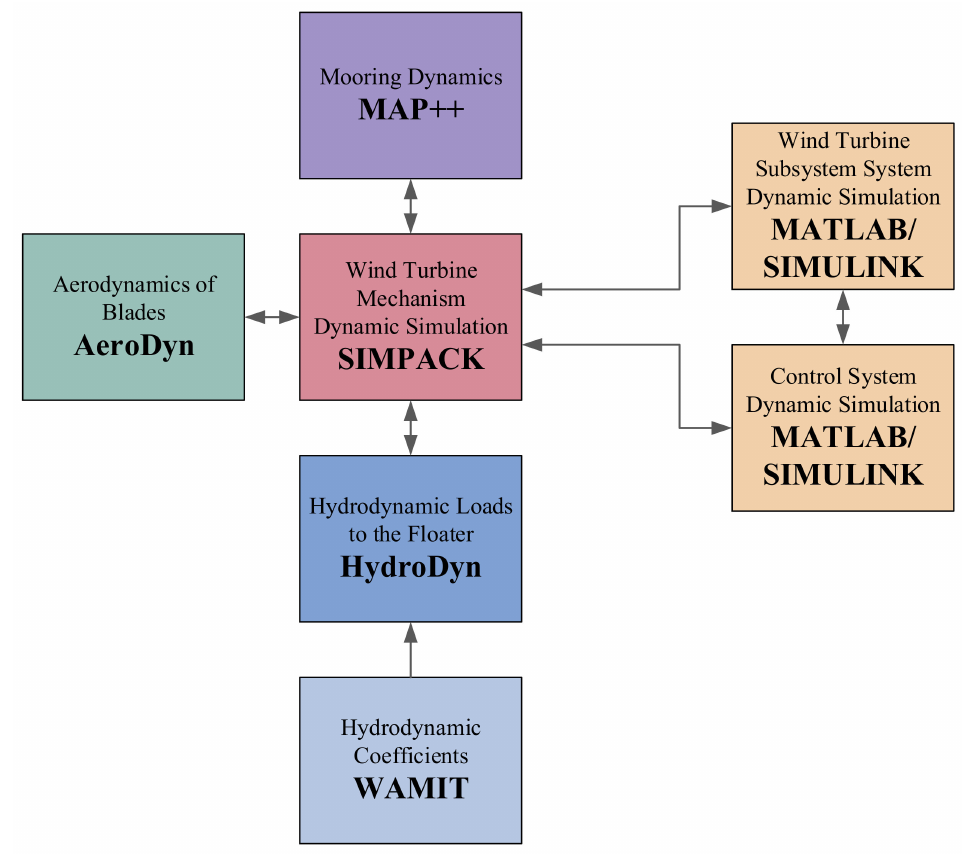
Figure 2. Dynamic co-simulation